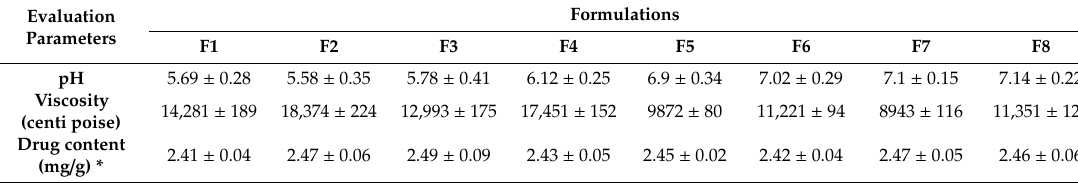
Table 2. Physicomechanical properties of prepared nebivolol hydrogel formulations.